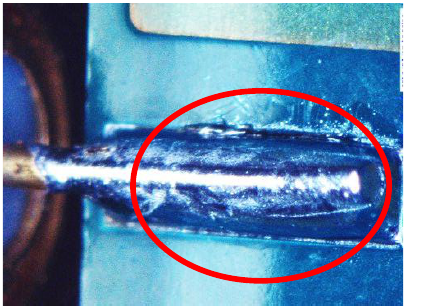
Figure 1. Directly soldered structure. ( a ) Photo of the directly soldered structure; ( b ) Model of the directly soldered structure.